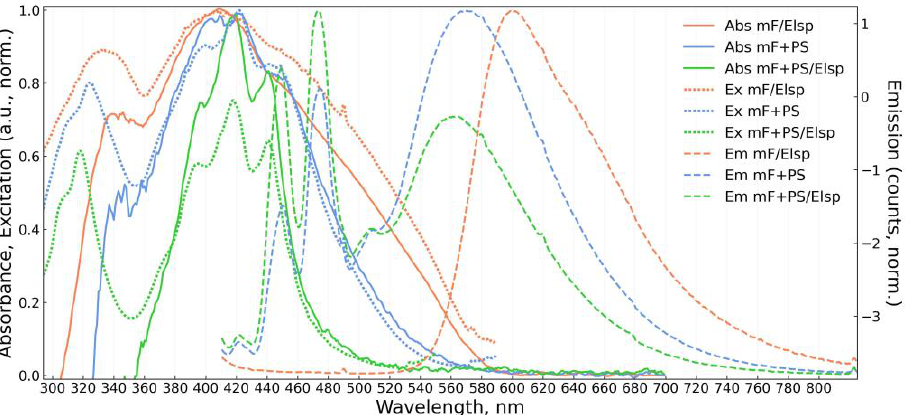
Figure 7. Absorbance (Abs, solid), excitation (Ex, dotted), and emission (Em, dashed) spectra of ob-